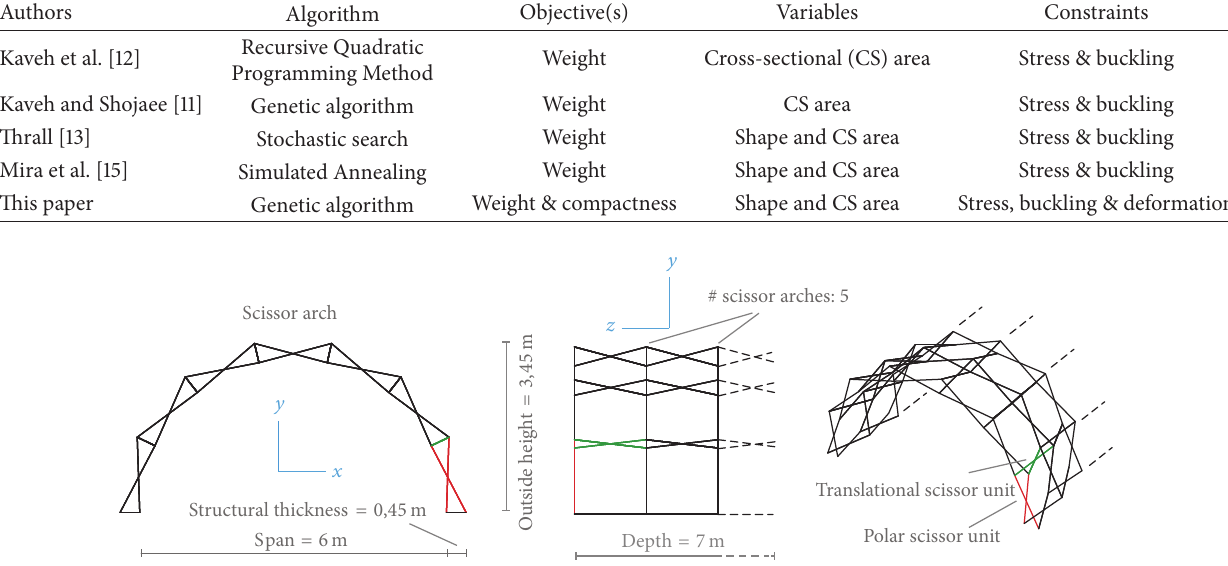
Figure 2: The arches of the barrel vault are made of polar units and, in-between, translational units are placed to hold the arches together. The number of arches depends on the number of unit (in this figure, there are 7